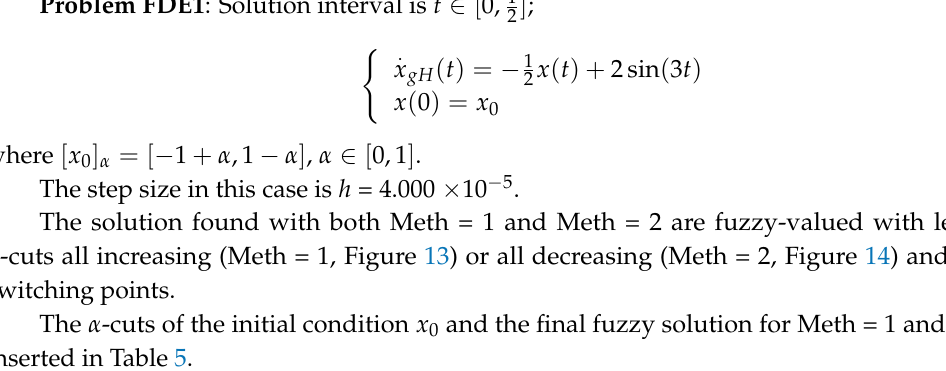
(cid:110) (cid:111) i − 1 | i = 1,...,10 , the table contains 10